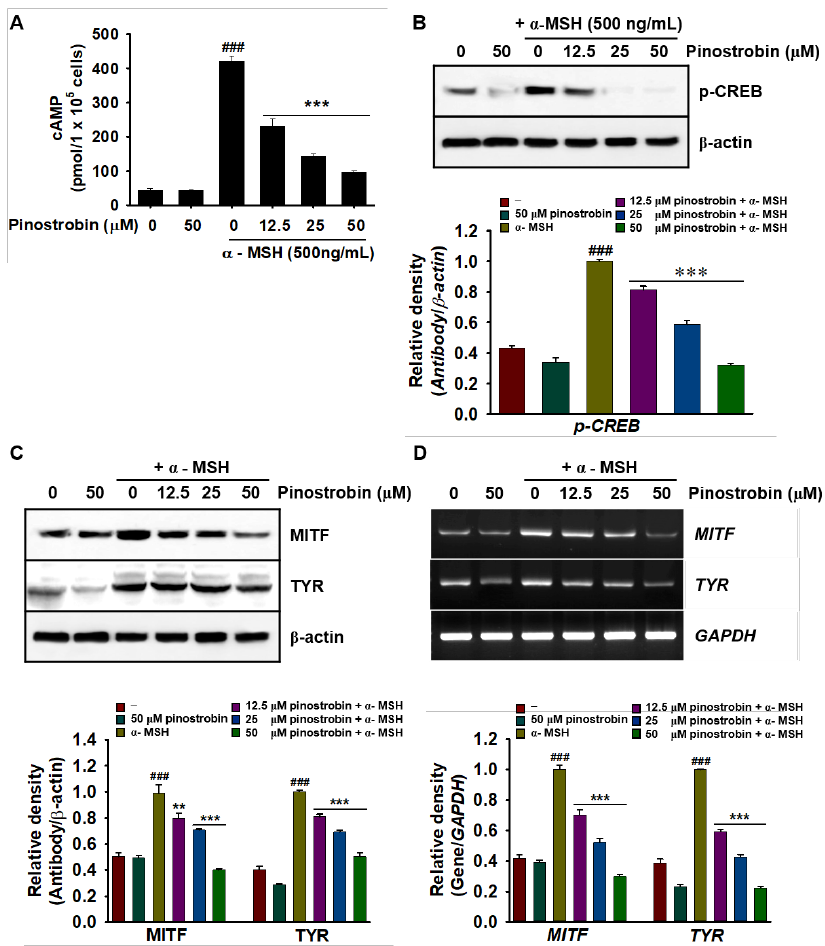
Figure 5. Pinostrobin inhibits α -melanocyte-stimulating hormone ( α -MSH)-induced melanogenic signaling pathway. ( A ) Intracellular cAMP levels of B16F10 melanoma cells following pretreatment